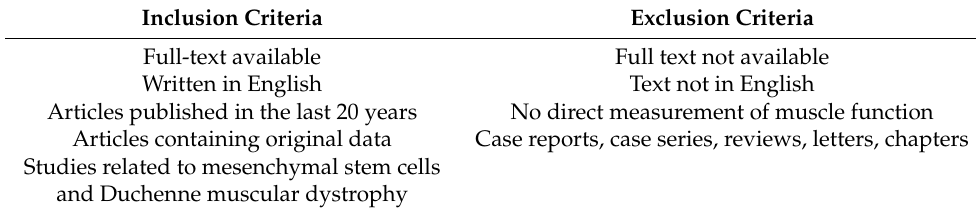
Table 1. Inclusion and exclusion criteria for studies. Inclusion Criteria Exclusion Criteria Full-text available Full text not